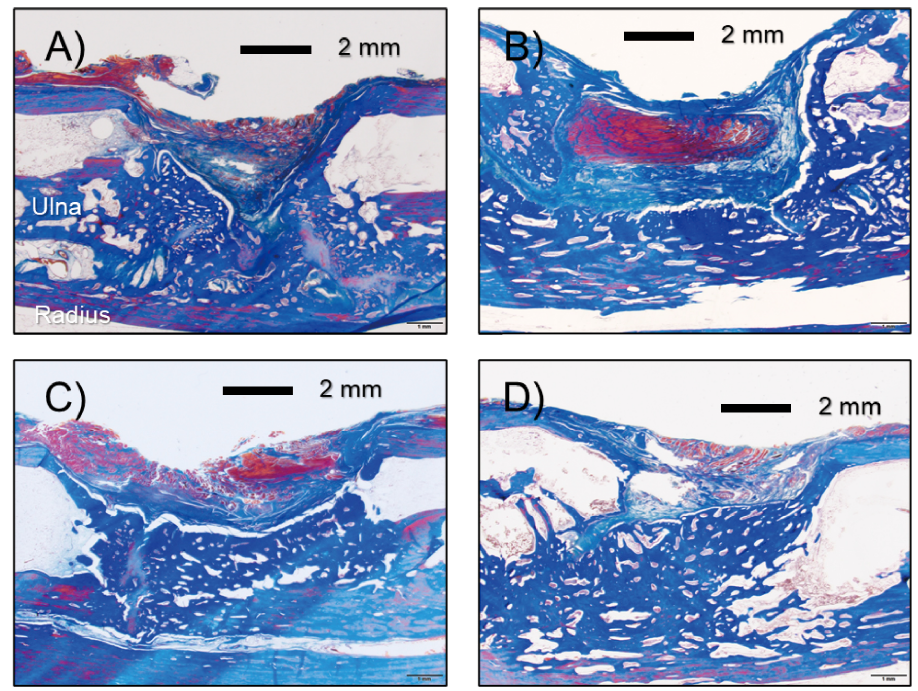
Fig 5. Histological section was stained with Masson’s trichrome as a function of plasma treatment time: 5A for 0 min, 5B for 5 min, 5C for 10 min, and 5D for 15 min, respectively. Figures include a 2 mm scale bar.